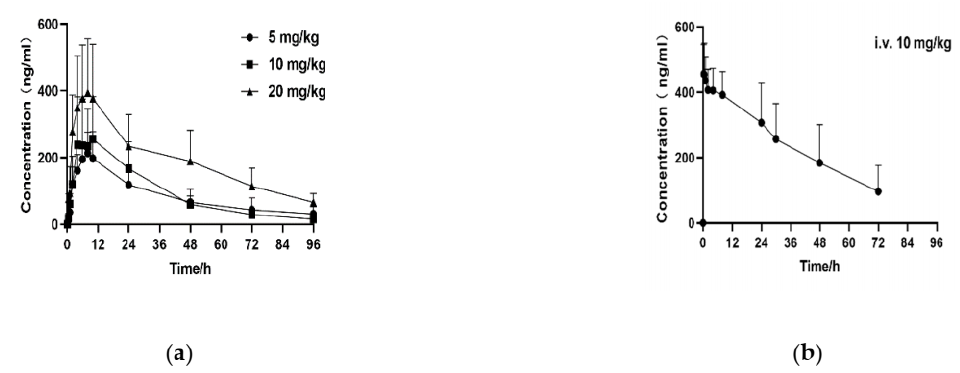
Figure 4. Mean plasma concentration-time curves of Hu7691 in beagles following ( a ) oral administra- tion and ( b ) intravenous